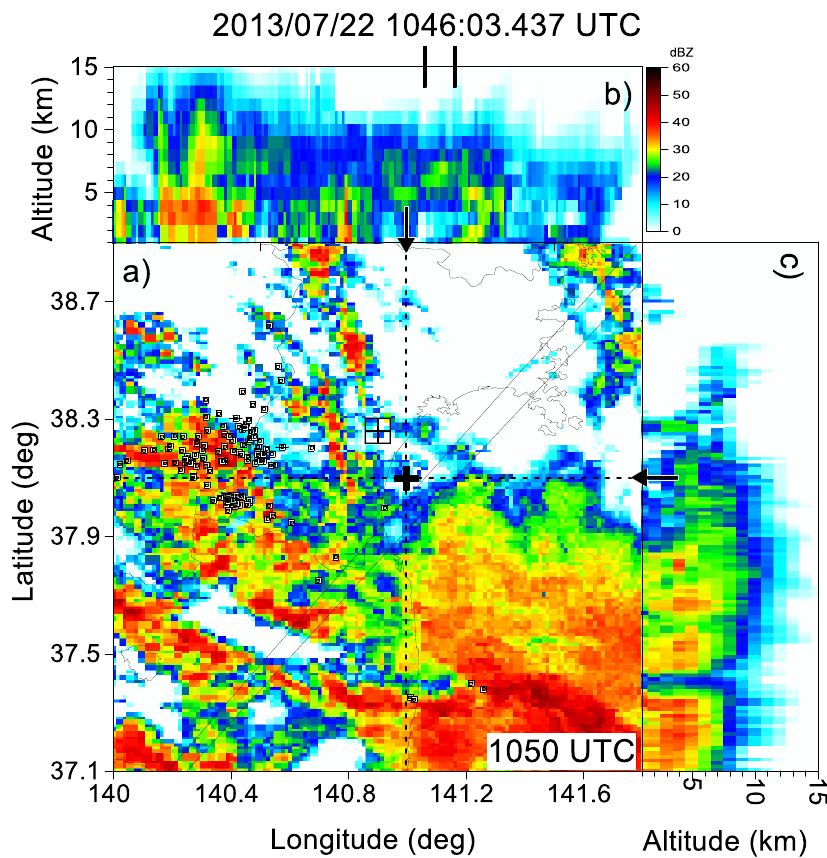
Figure 6. The horizontal and vertical cross-sections of the parent MCS with respect to the first sprite at 1046:03.437 UTC. ( a ) Open square (□) and bold plus (+) signs show in-cloud lightning locations and sprite-producing +CG during a 10 min period before 1050 UTC; the dashed lines indicate the longitude and latitude lines at +CG; plus within square sign shows the location of wind profiler at Sendai; the solid line shows the azimuth of sprite elements from Mt. Fuji; and radar reflectivity at an altitude of 2 km is displayed. Vertical cross-sections of reflectivity along the longitude ( b ) and latitude ( c ) at the sprite-producing +CG location are shown. The arrows are sprite-producing +CG points. The bars on the top axis ( c ) indicate the intersections between the longitude line at the +CG point and the azimuth of sprite elements from the summit of Mt. Fuji.